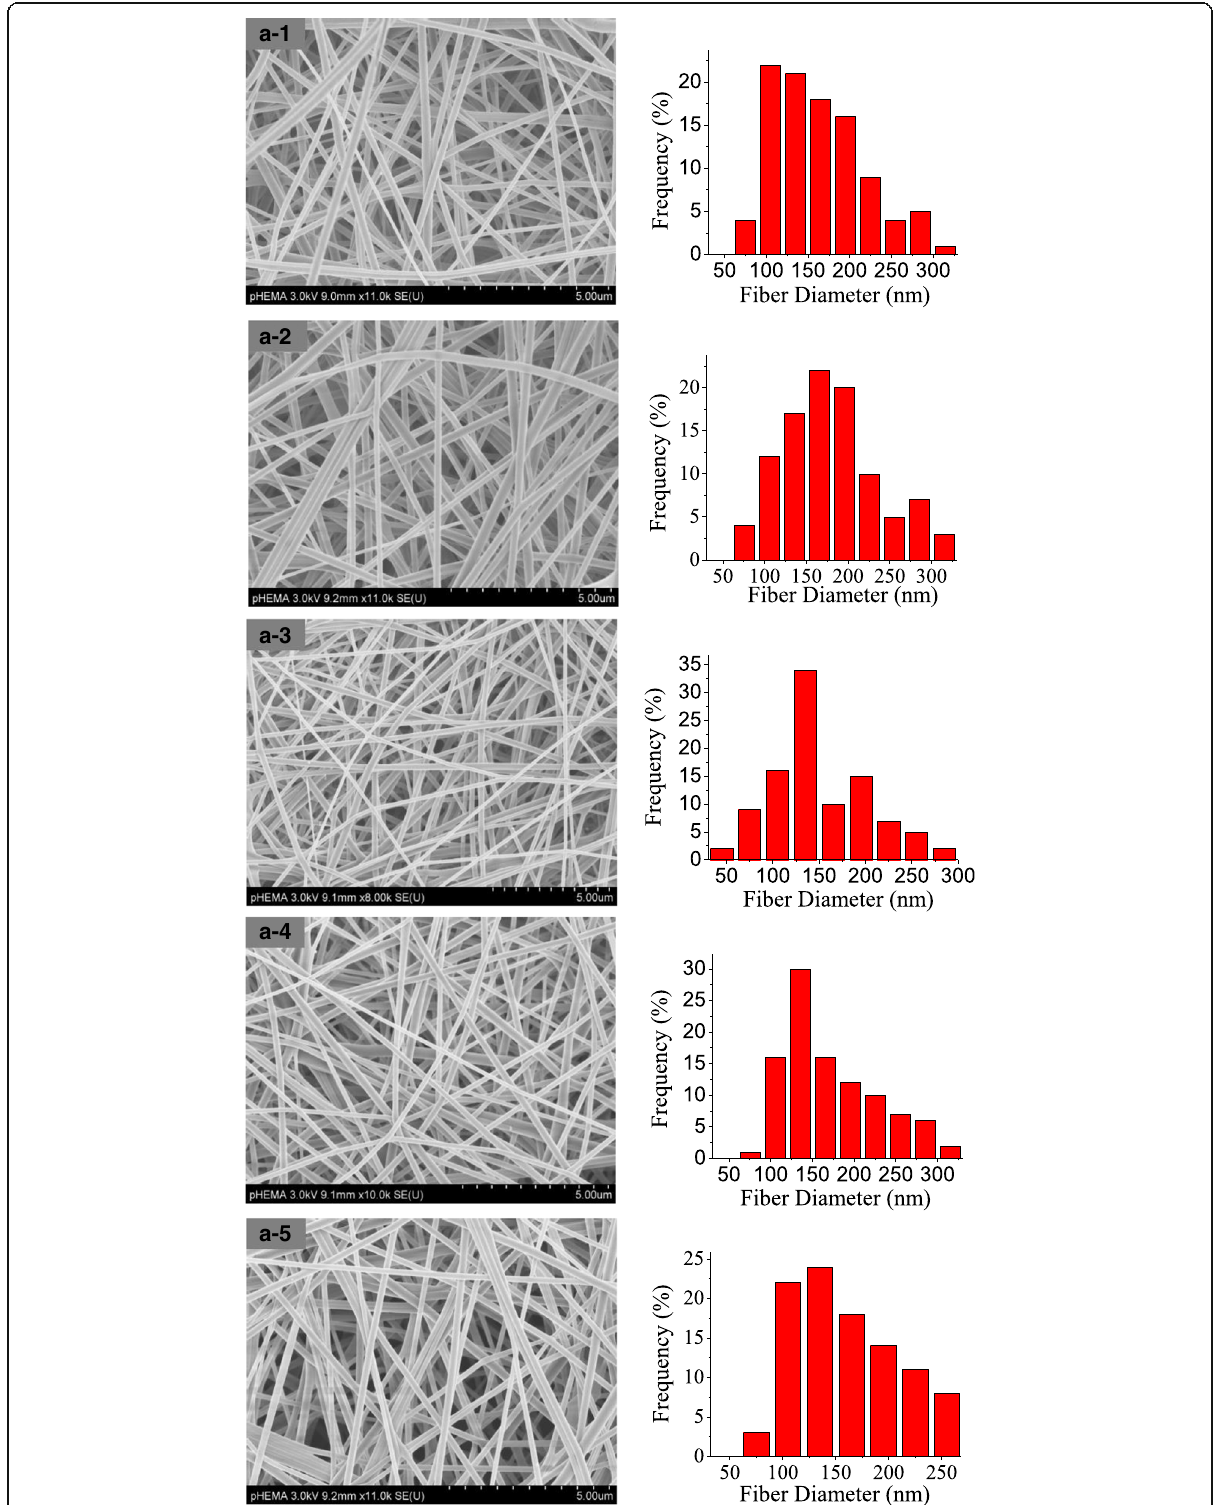
Fig. 7 SEM images of PVA nanofibers prepared by MFSE at the different spinning time ( a-1 5 min, a-2 10 min, a-3 15 min, a-4 20 min, a-5 : 25 min). The right figures were the according diameter